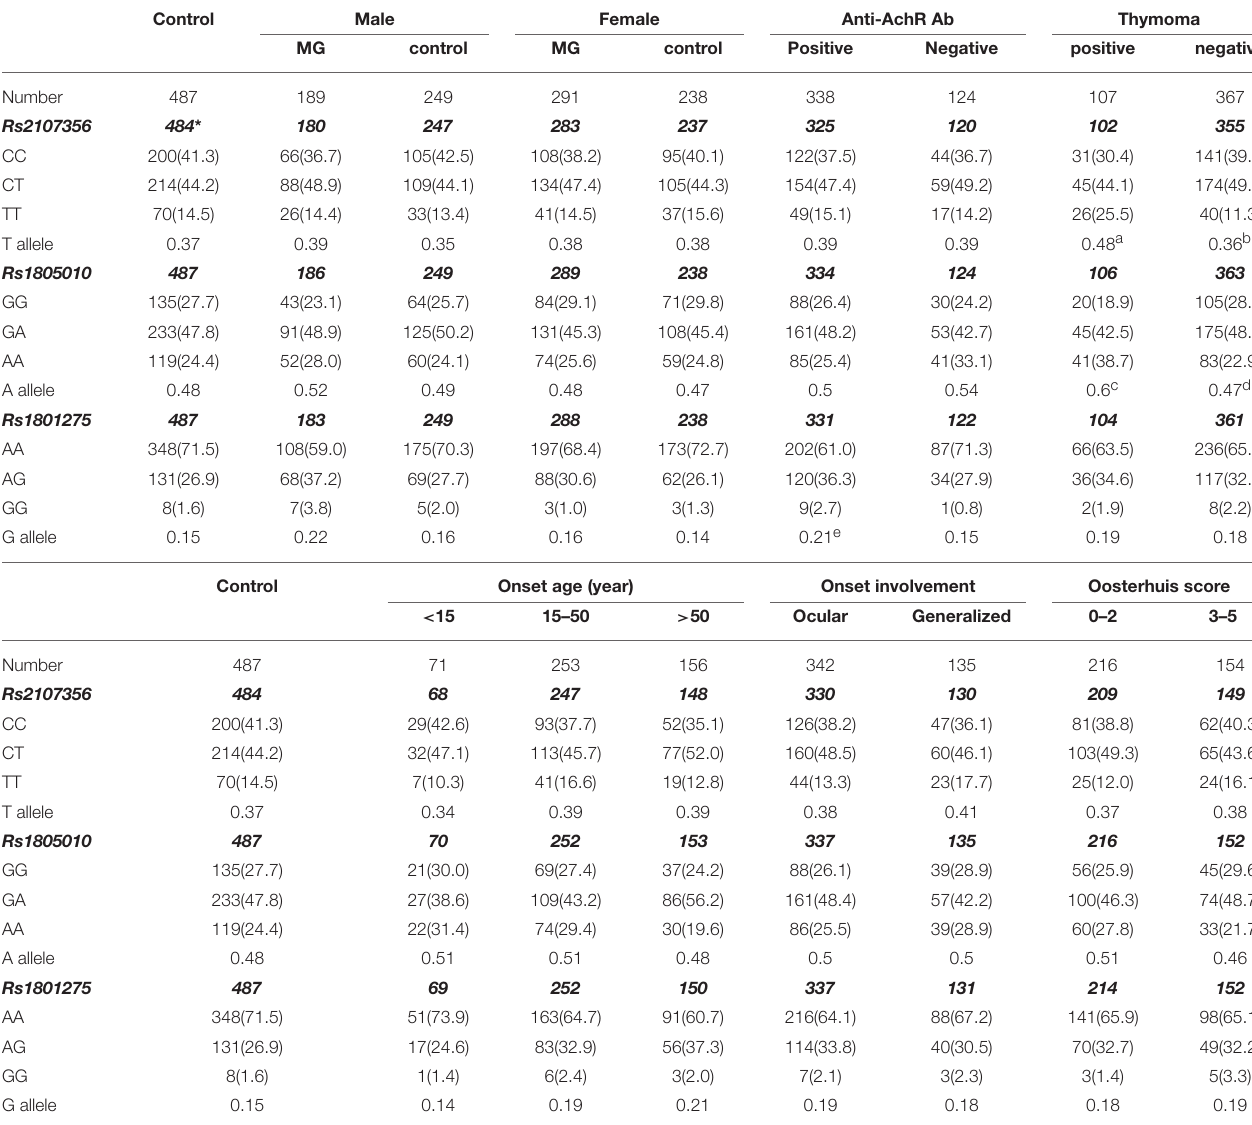
TABLE 3 | Frequencies of alleles and genotypes of rs1805010, rs1801275 and rs2107356 in MG subgroups and controls [case